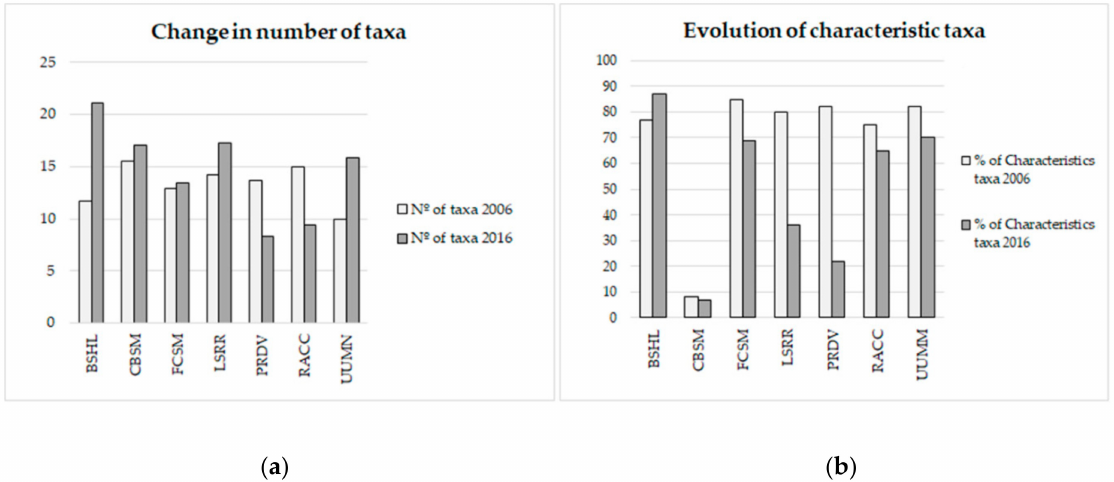
Figure 2. ( a ) Number of species observed for each plant community in the 2006 and 2016 samples. ( b ) Number of characteristic species observed for each plant community in the 2006 and 2016 samples. The communities are: Bromo scopariae - Hordeetum leporini (BSHL) Carduo bourgaeani-Silybetum marianum (CBSM); Fedio cornucopiae-Sinapietum mariei (FCSM); Linario spartei- Raphanetum raphanistri (LSRR); Papaverido rhoeadis-Diplotaxietum virgatae (PRDV); Resedo albae-Chrysanthemetum coronarii (RACC) and Urtico urentis-Malvetum neglectae (UUMN). The characteristic species of each community were assigned according to Rivas-Martinez